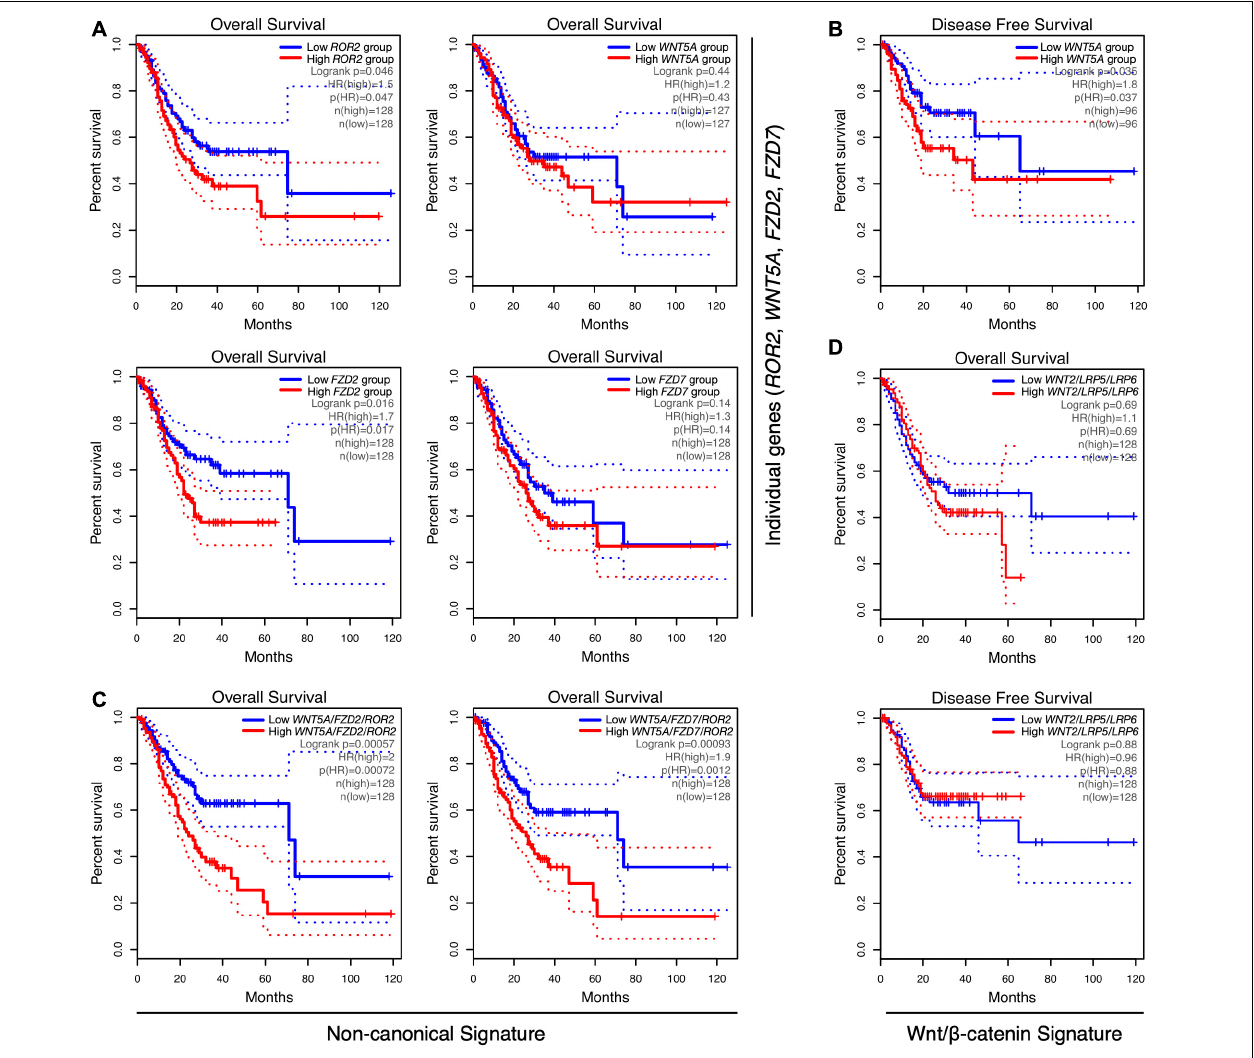
FIGURE 2 | Correlation between gene expression and overall survival in GC. (A) Correlation between ROR2 , WNT5A , FZD2 , and FZD7 gene expression and overall survival (OS), using terciles, in GEPIA. (B) Correlation between low and high WNT5A expression and disease-free survival (RFS), using quartiles. (C) Correlation between the WNT5A / FZD2 / ROR2 (left) and WNT5A / FZD7 / ROR2 (right) gene signatures and OS, using GEPIA. (D) Correlation between the Wnt/ β -catenin gene signature WNT2 / LRP5 / LRP6 , and OS (top) or RFS (bottom), by using terciles. The number of samples per condition, denoted as n(high) (red lines) and n(low) (blue lines), as well as the HR and Log-rank p -values, are indicated in each plot. Dotted lines show the 95% confidence interval